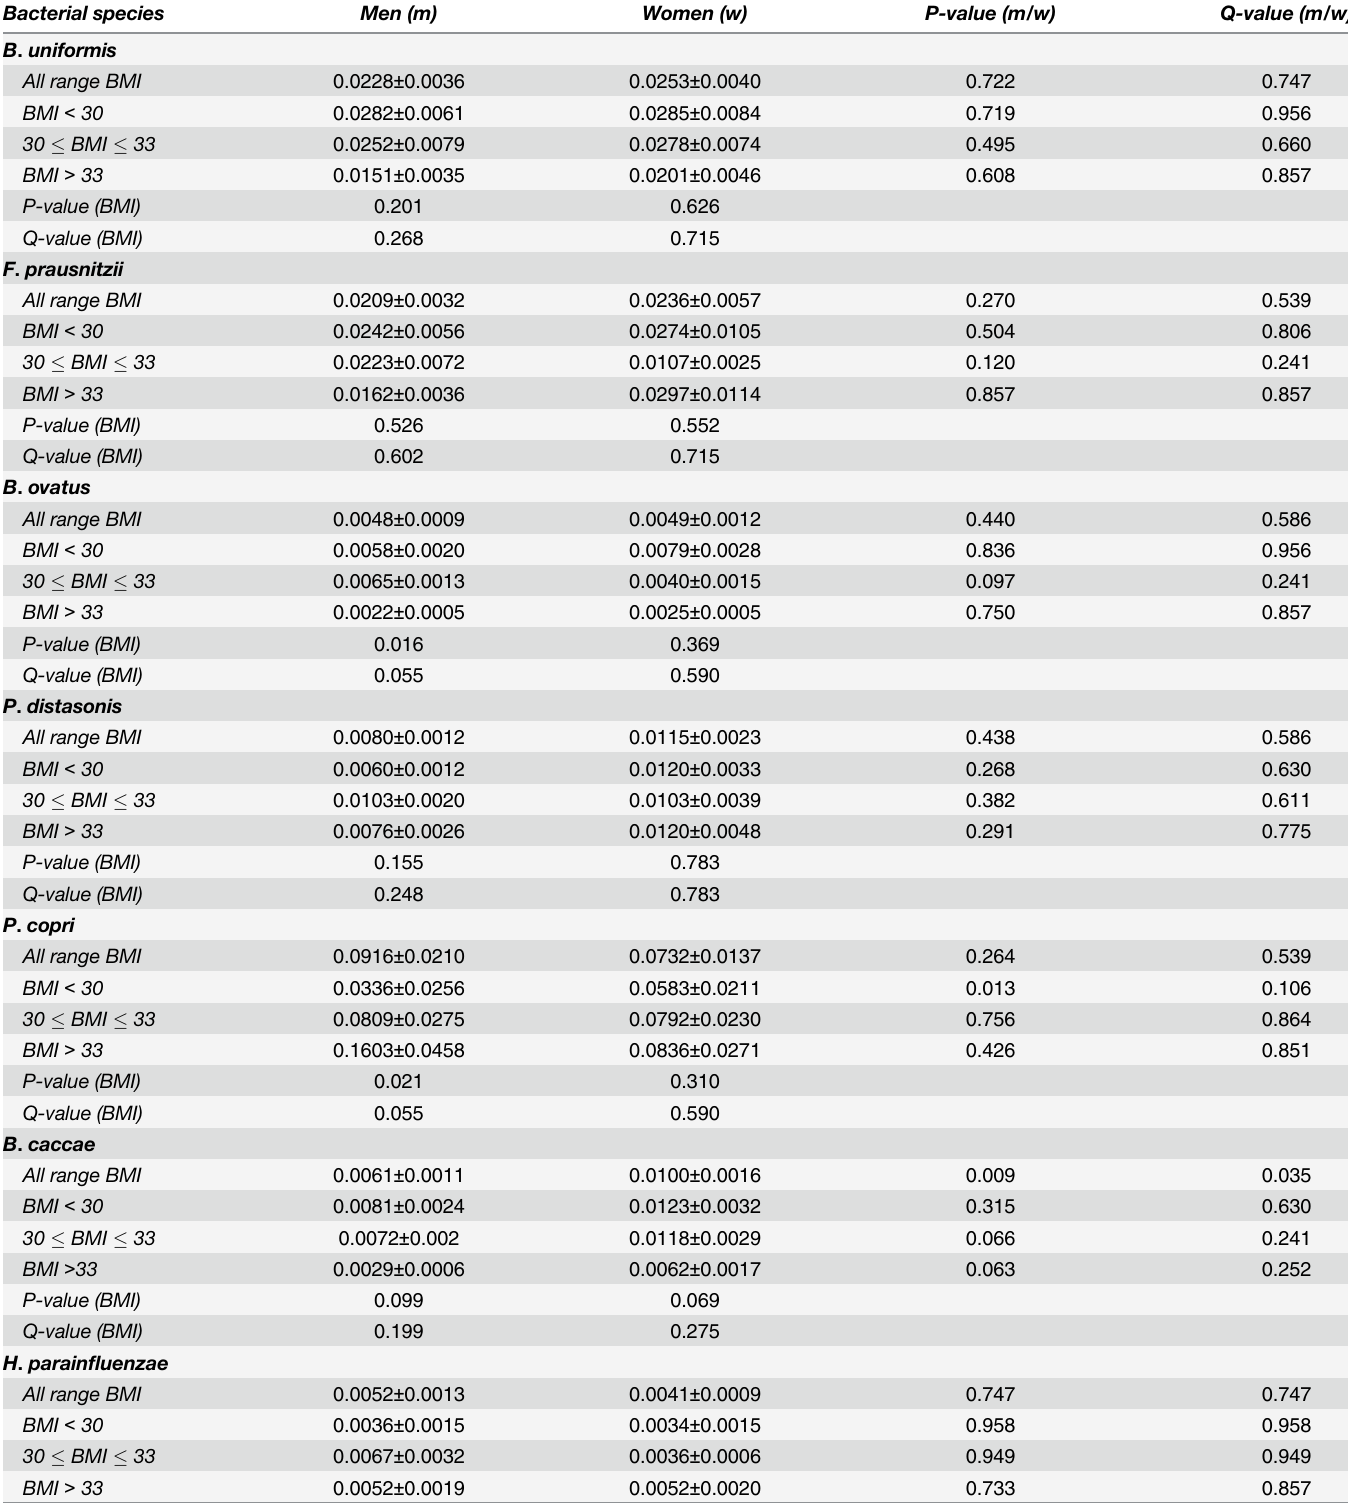
Table 2. Gender differences in the gut microbiota at bacterial species